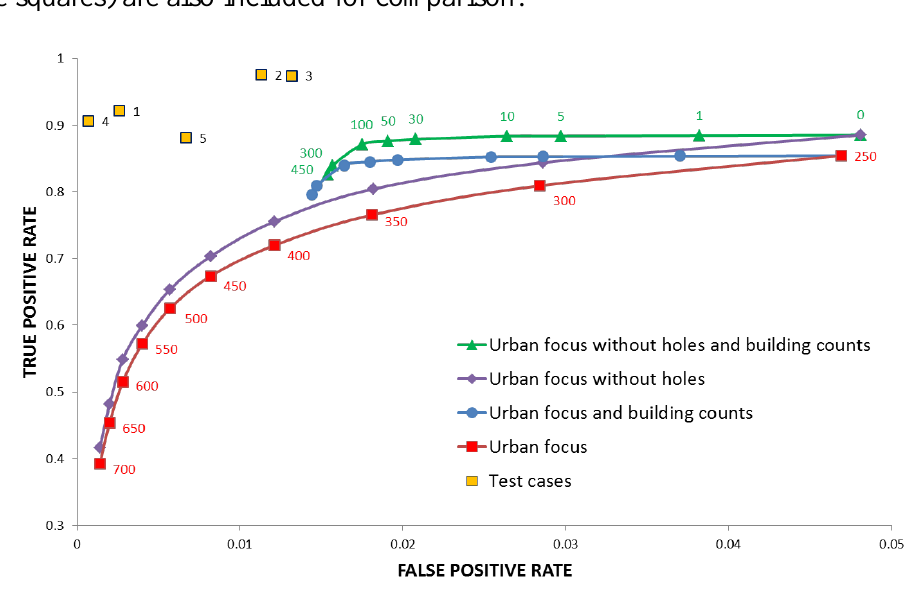
Figure 5. Receiver Operator Curve for the Ribeirao Preto test site against the first reference data set in Figure 3a. The term ―without holes‖ means that the urban vegetation (e.g., urban parks) is considered as part of the urban area. The term ―count‖ refers to the minimum number of buildings per agglomerate. Final results for five other CBERS scenes (orange squares) are also included for